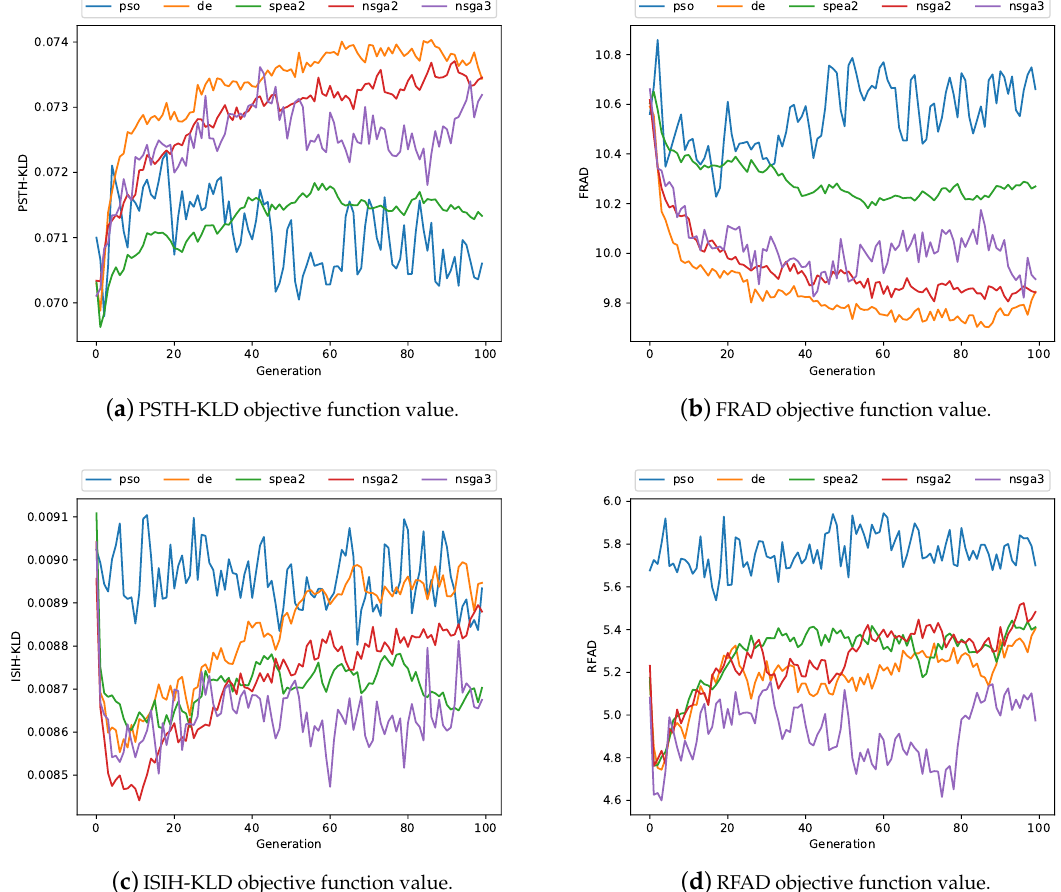
Figure 7. Average value of the objective functions over 100 generations: Particle Swarm Optimisation (PSO) (blue), DE (orange), SPEA2 (green), NSGA-II (red) and NSGA-III (purple).